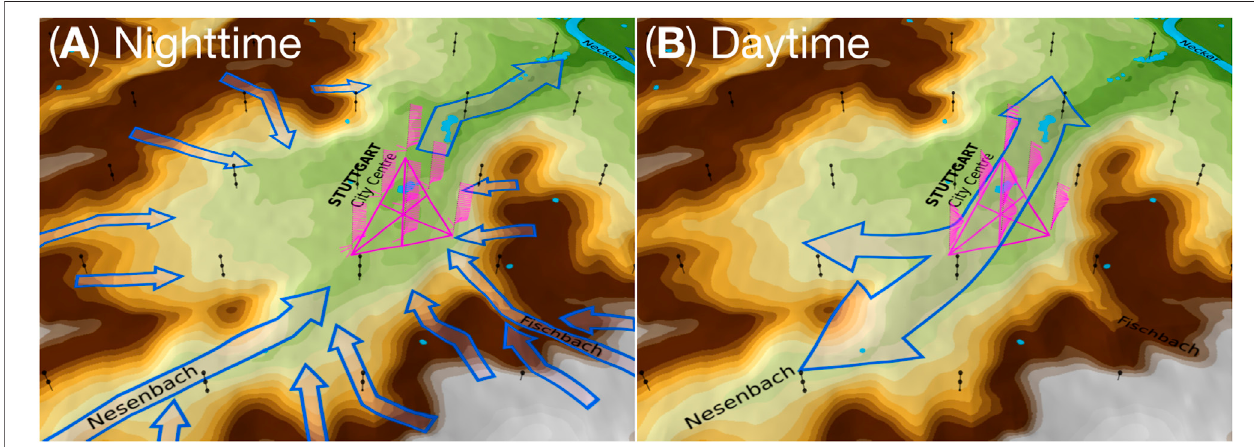
FIGURE 13 | Conceptual diagram of competing fl ow regimes during weak wind conditions in Stuttgart City Centre for (A) night-time drainage fl ow and (B) topographically channelled fl ow during daytime. The perspective is viewed from the south. Black lines and points highlight the altitude up to 500 m a.s.l. in 100 m intervals, and vertical wind pro fi les are included for illustration purposes as magenta windbarbs. The topography and color gradient from Figure 1A are shown as background.